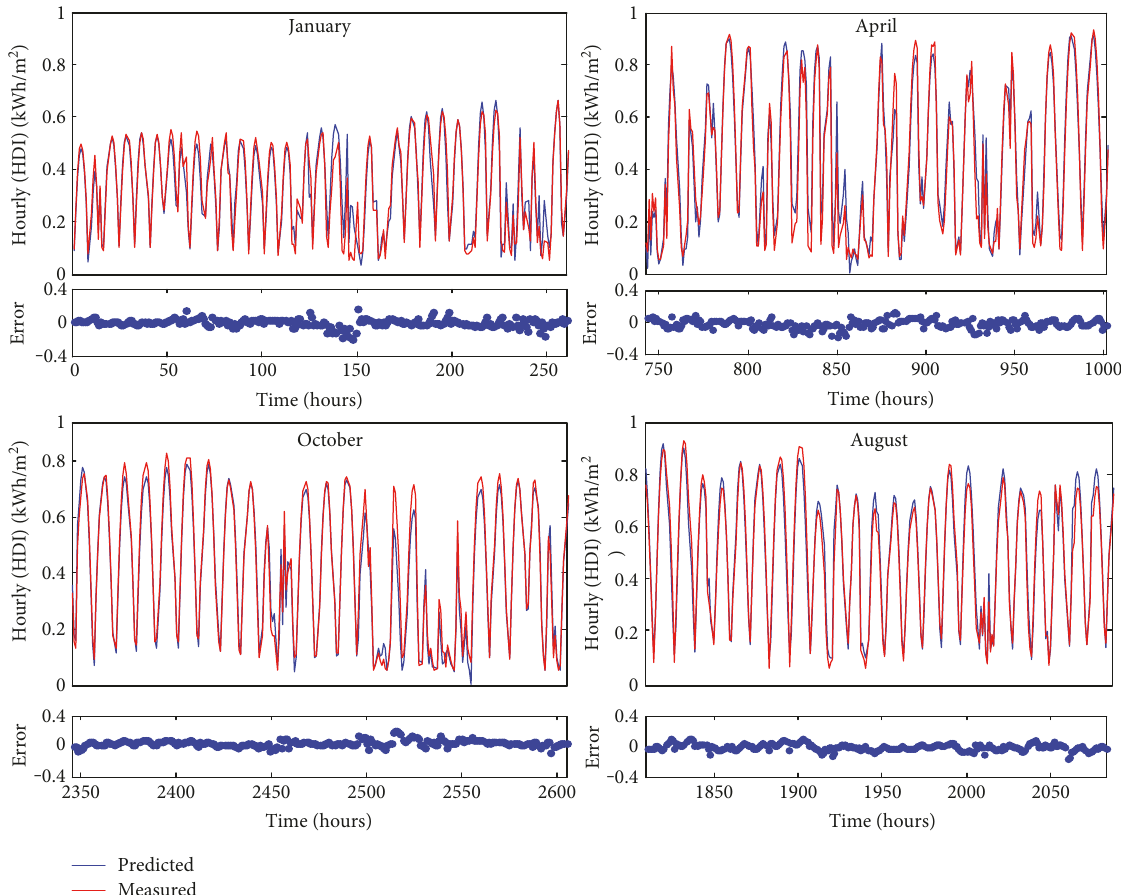
Figure 7: Measured and predicted hourly (HDI) for four months representing di ff erent seasons.